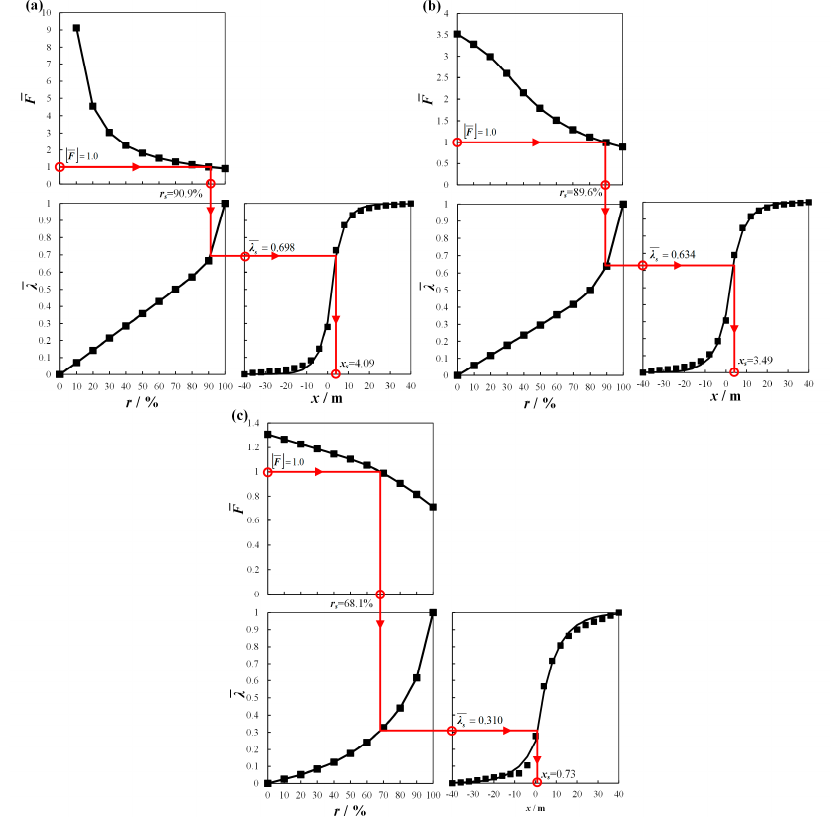
Figure 15. Installation location for the initial support: ( a ) case 1, ( b ) case 2, ( c ) case 3.